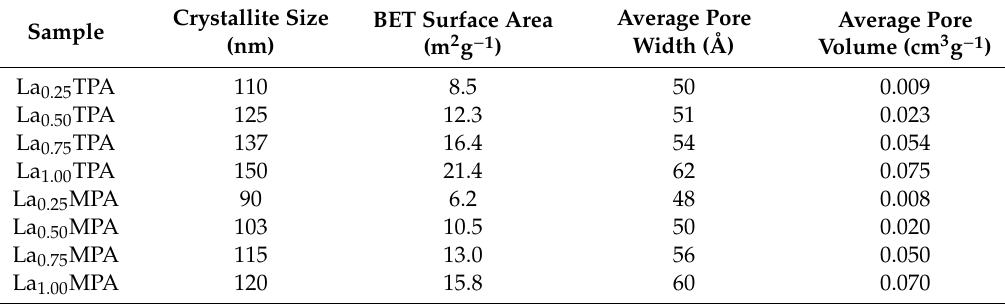
Figure 1. XRD patterns of ( A ) La x TPA and ( B ) La x MPA samples Table 1. Data obtained from XRD and N 2 -physisorption